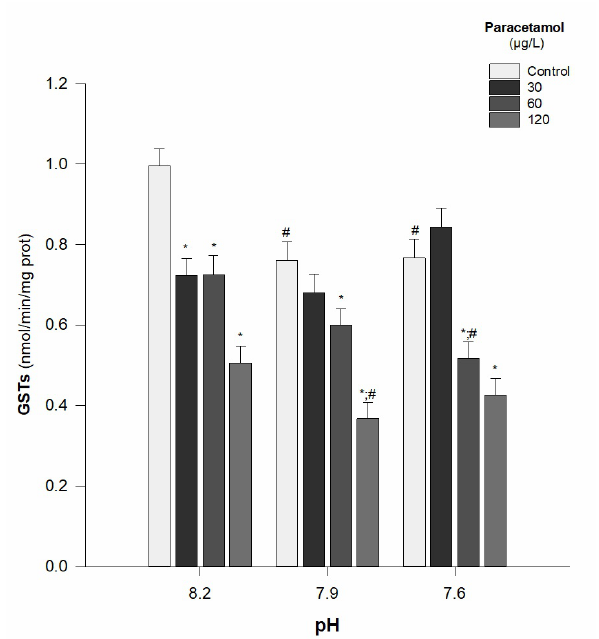
Figure 2. Glutathione S-transferases (GSTs) activity in Hediste diversicolor exposed to paracetamol (0, 30, 60, and 120 µg/L) under the pH values of 8.2, 7.9, and 7.6. Statistical differences among PAR concentrations (30, 60, and 120 µg/L) and the control group (0 µg/L) within each pH level are represented with “*”. Statistical differences between pH treatments (7.9 and 7.6) and the pH control group (8.2) within each PAR concentration are represented with “#”. Statistics refer to Dunnett’s tests (following a Two-Way ANOVA). Values are the mean ± standard errors.